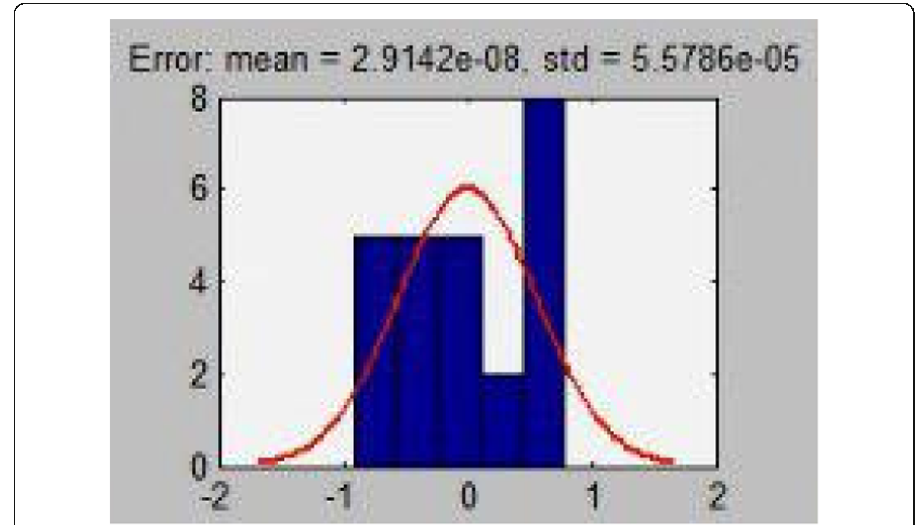
Fig. 16 The subtractive clustering MSE. There are some clustering methods like K-Means, FCM, and subtractive. To find which one is the best for our research, we have clustered the customers using K-Means, FCM, and subtractive clustering methods and compared the methods ’ MSEs. The MSEs (Mean-Square Error) of the subtractive is shown in Fig. 16. The error mean is = 2.9142e-0.8 and std. = 5.5786e-0.5 The Mean squared error (MSE) measures the average of the squares of the